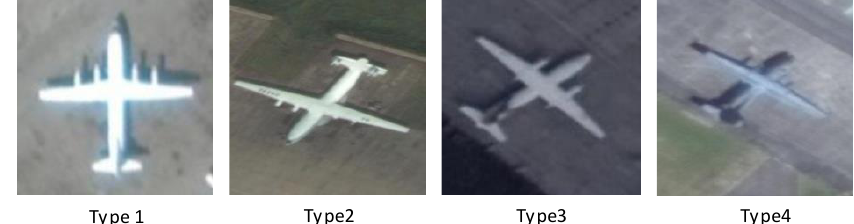
Figure 7. Some hard examples in the dataset. Type-1, Type-2, Type-3, and Type-4 are four sub-categories of transport aircraft, they are very difficult to be distinguished in low-resolution remote sensing